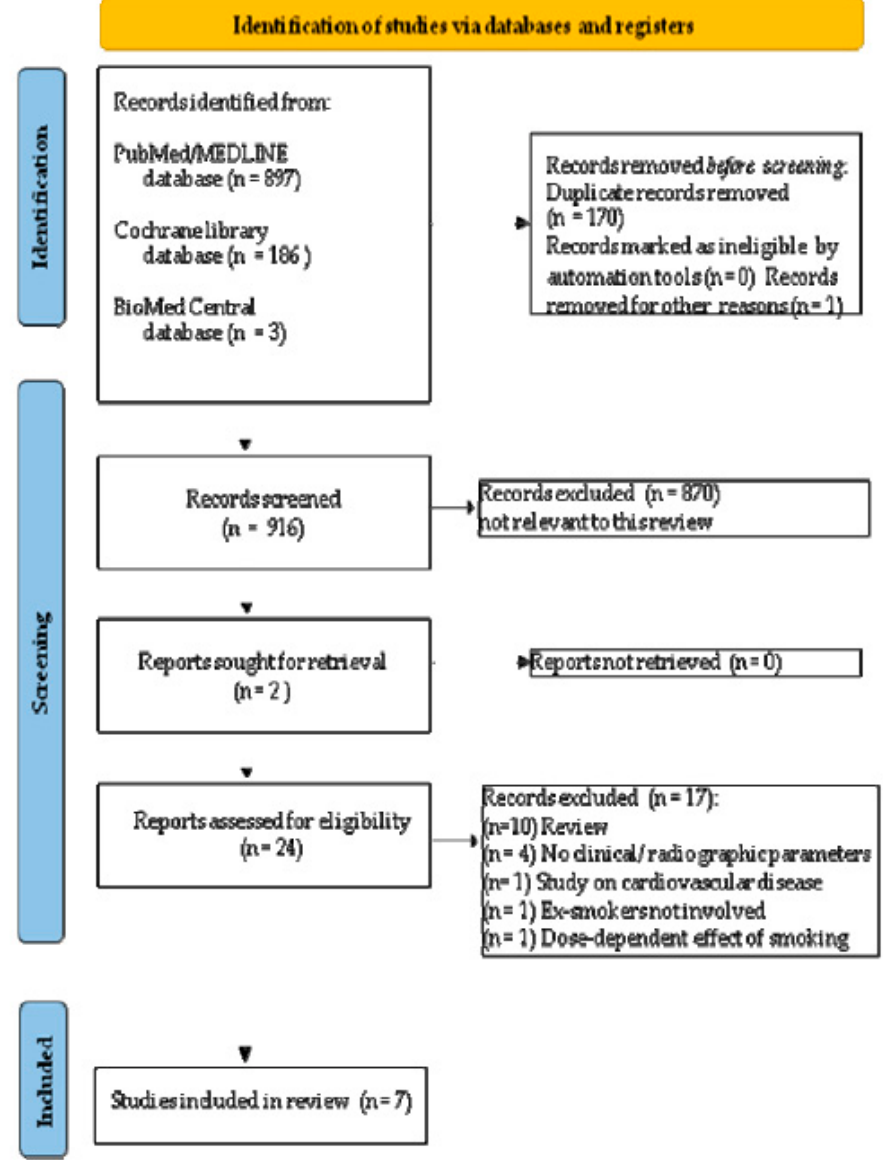
Figure 1. PRISMA 2020 flow diagram for new systematic reviews which included searches of databases and registers only.